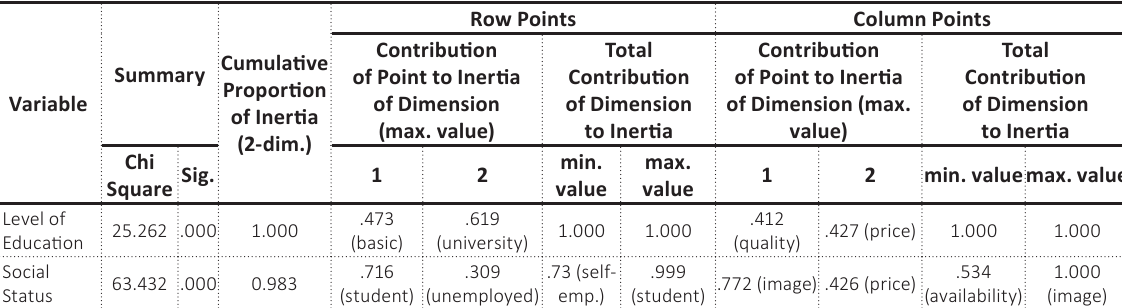
Table 8. Cumulative